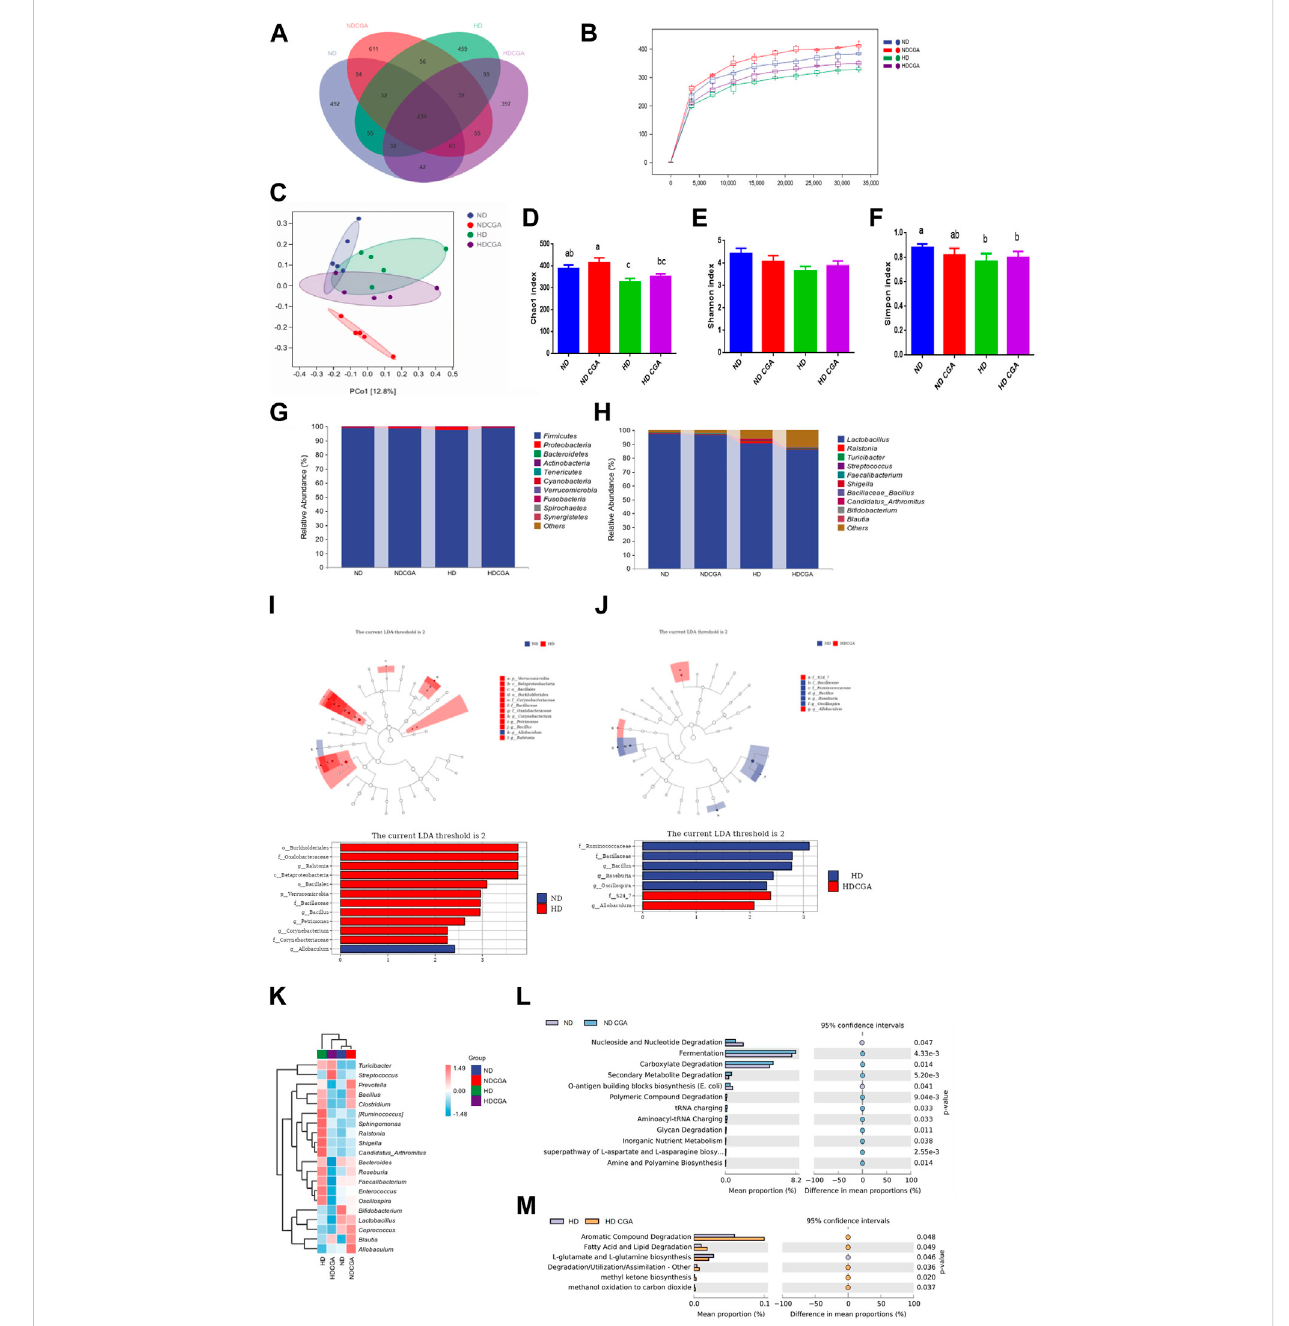
FIGURE 4 The impact of CGA consumption on the bacterial population in the ileum of chickens from the ND, HD, ND CGA, and HD CGA groups. (A) Venn diagram showing unique and shared numbers of genera predicted. (B) Rarefaction Curve. (C) Two-dimensional OTU abundance based principal coordinate analysis (PCoA) of ileac microbiota. D-F. CGA was found to increase caecal microbial alpha diversity as measured by Simpson and Chao1 indicators. (G) Microbial composition at the phylum level. (H) Microbial composition at the genus level. (I-J) Leaf and bar plots obtained by lineardiscriminantanalysiseffectsize(LEfSe)analysisshoweddifferencesintheabundanceofbroilerfecalmicrobes. (K) Agraphicalrepresentationofthe rangeofspeciespresentinthetoptwentygeneraineachsample.Pinkrepresentspositivecorrelationandblueindicatesnegativecorrelation. (L-M) COG functional classi fi cation and differences in COG